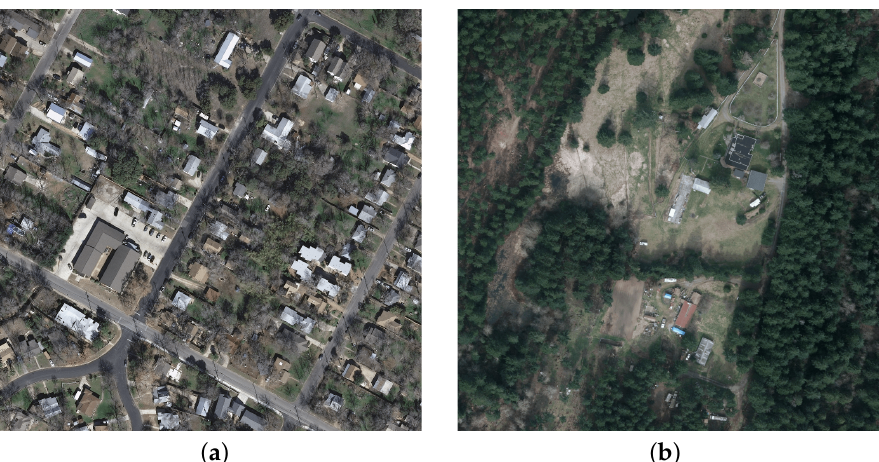
Figure 1. Images from the Inria Aerial Image dataset [6]; ( a , b ) are sample images from the city of Austin and Kitsap County in the